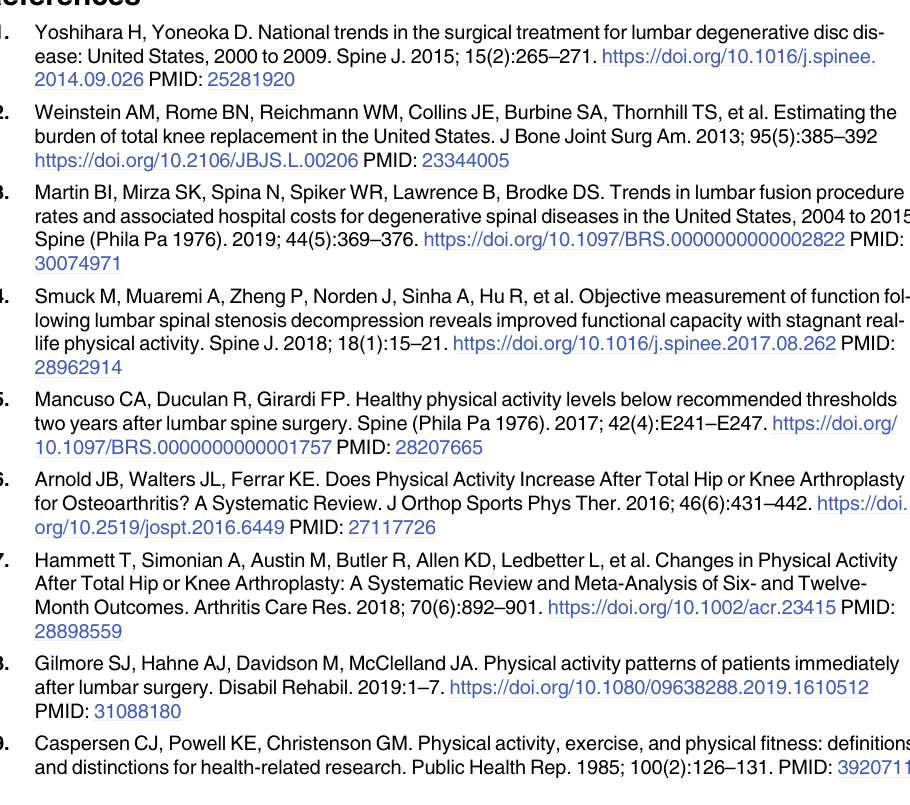
S3 Table. Search strategy for PsycINFO database. S4 Table. Search strategy for EMBASE